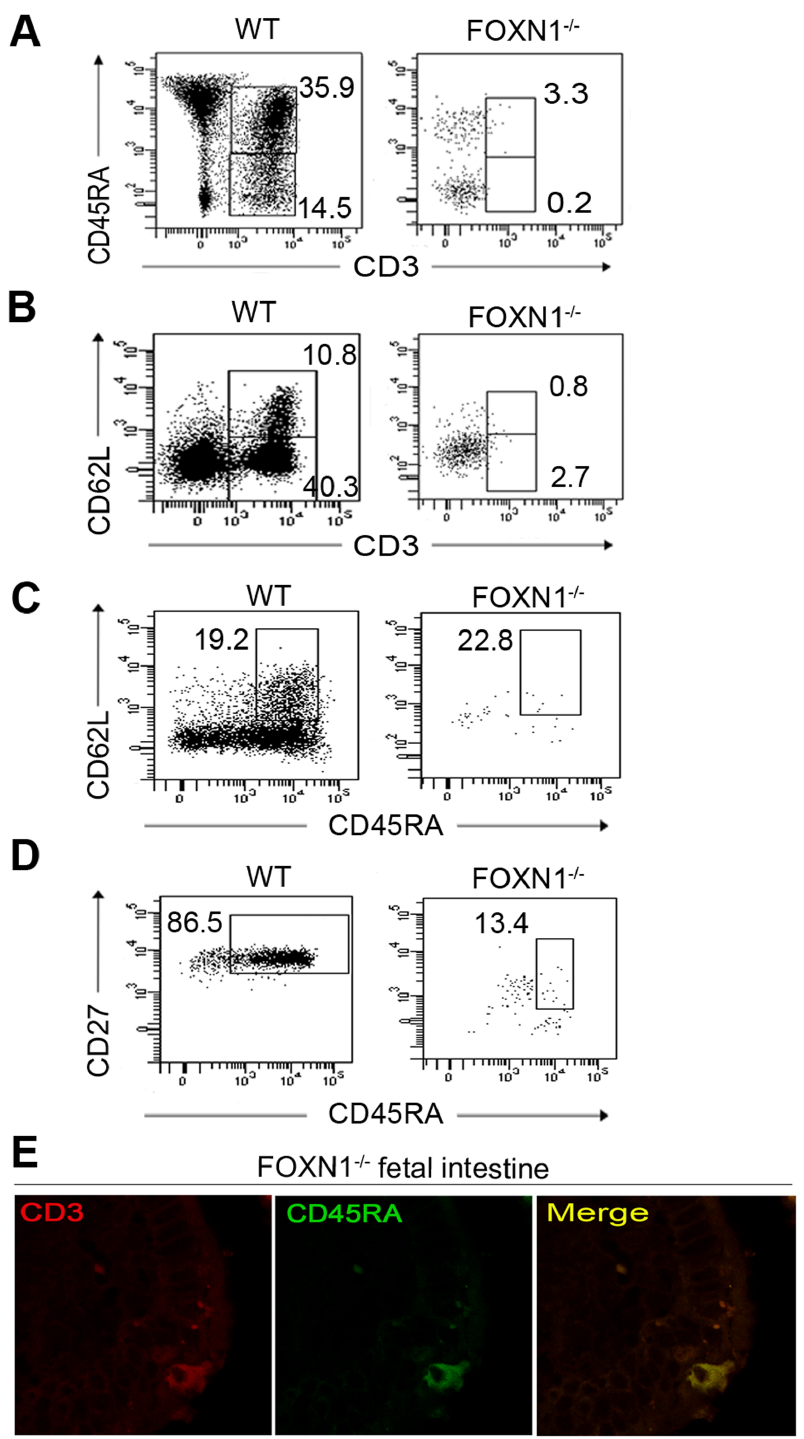
Figure 3. Lymphocytes with naive phenotype in cord blood and intestine. Flow cytometry of CBMCs from normal and FOXN1 2 / 2 fetuses matched for gestational age (16 weeks of gestation). Dot plots show the expression pattern of the naı¨ve cell markers. (A) Frequencies of CBMCs expressing both CD45RA and CD3 markers. (B) Frequencies of CBMCs expressing both CD62L and CD3 markers. (C) Frequencies of CBMCs coexpressing CD45RA and CD62L markers. (D) Frequencies of CBMCs coexpressing CD45RA and CD27 markers. Experiment in (A), (B), (C) and (D) was repeated two times. Data were obtained by gating first on viable cells and later on CD45 + cells (A and B) or finally also on CD3 + (C and D). (E) Confocal microscopy of fetal intestinal sections labeled with anti-human CD3 (red) and anti-human CD45RA (green). Representative results from three independent experiments with two samples are shown.